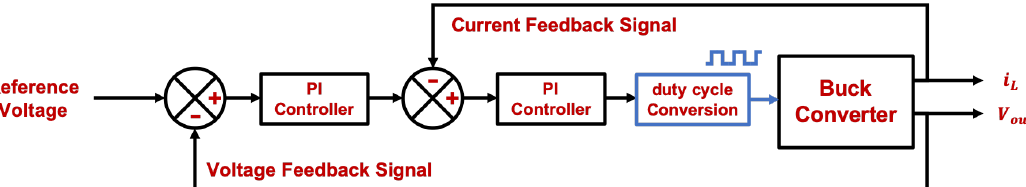
Figure 8. Cascade controller scheme for voltage and current in a buck converter, symbolizing the relationship of the controllers with the real converter.